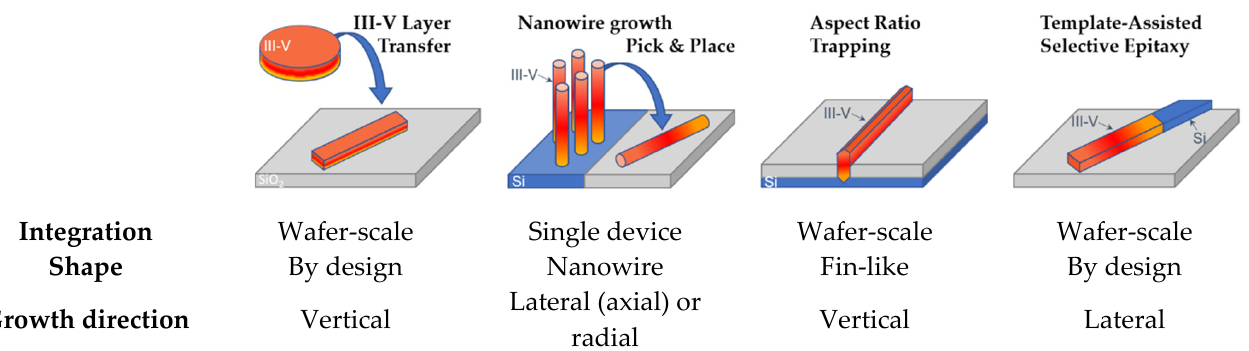
Figure 1. Schematic comparison for several integration methods for III-Vs (red) on Si (blue) and SiO 2 (grey). Color shading symbolizes the growth direction and thereby natural orientation of heterostructures or doping profiles.